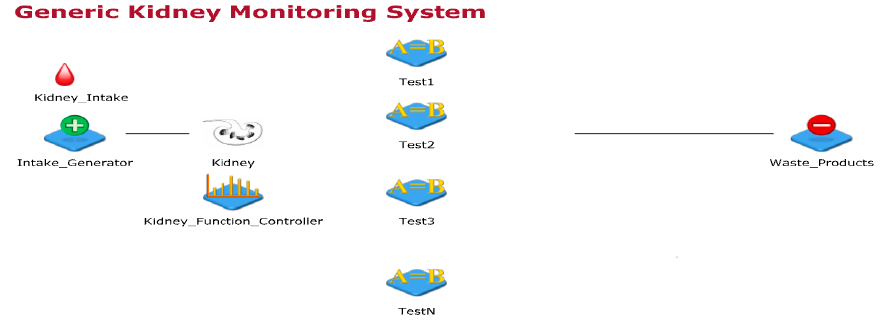
Figure 2. Generic Kidney Monitoring